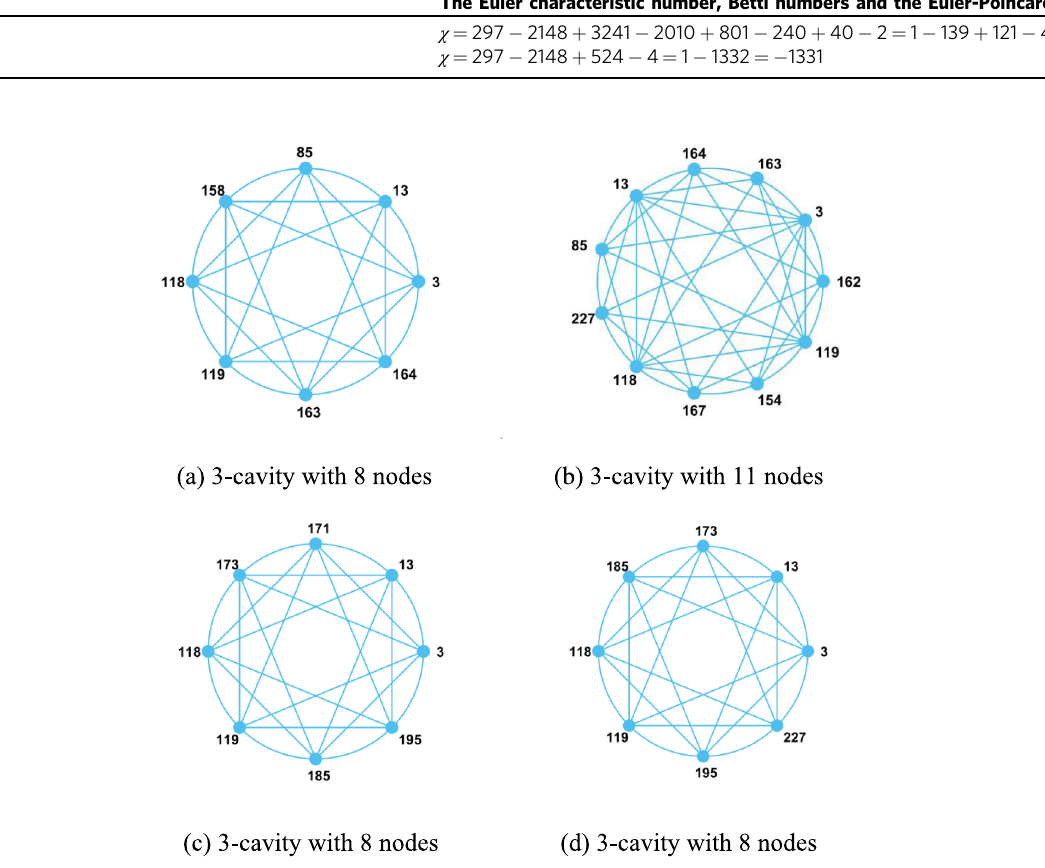
Fig. 3 Four 3-cavities in the C. elegans neuronal network. a 3-cavity with 8 nodes; b 3-cavity with 11 nodes; c 3-cavity with 8 nodes; d 3-cavity with 8 nodes.